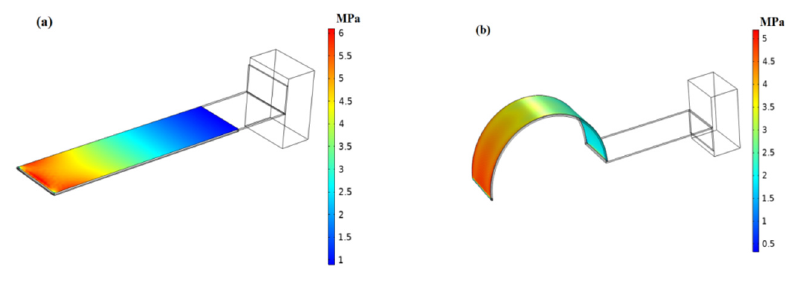
Figure 1. Finite-element model: ( a ) Straight beam, ( b ) Curve-shaped beam.